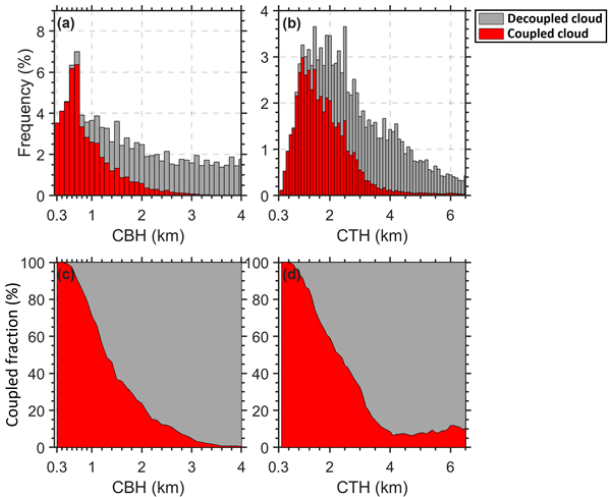
Figure 9. The height-dependent occurrence frequencies of (a) the cloud-base height (CBH) and (b) the cloud-top height (CTH) for coupled clouds (red bars) and decoupled clouds (grey bars). The relative occurrence frequencies of (c) the CBH and (d) the CTH for coupled clouds (red area) and decoupled clouds (grey